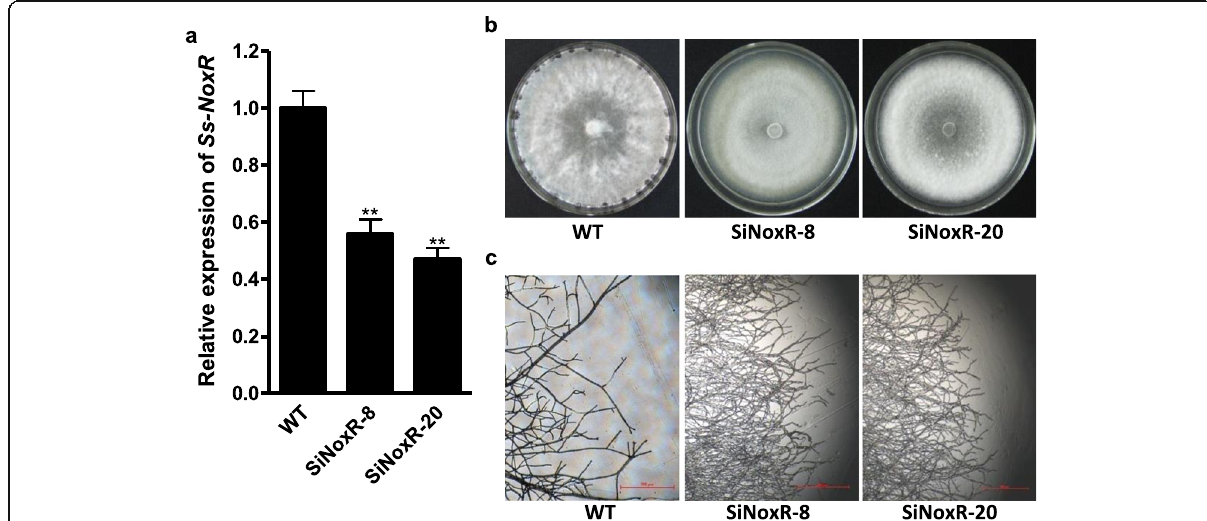
Fig. 5 Ss-NoxR -silenced transformants lost the ability to form sclerotia. a qRT-PCR analysis of Ss-NoxR transcript accumulation in Ss-NoxR -silenced transformants. Ss-NoxR expression in the wild-type strain Ep-1PNA367 served as control. Hyphal masses from 3-day-old colonies on PDA were collected for gene expression analysis. The cDNA abundance obtained from the wild-type strain was assigned a value of 1.0. Three independent replicates were performed. Values are means ± S.E. ** P < 0.01; one-way ANOVA. b Phenotypes of the wild-type strain EP-1PNA367 and Ss-NoxR - silenced transformants incubated on PDA for 10 d. c In vitro hyphal development of the wild-type strain and Ss-NoxR -silenced transformants. All